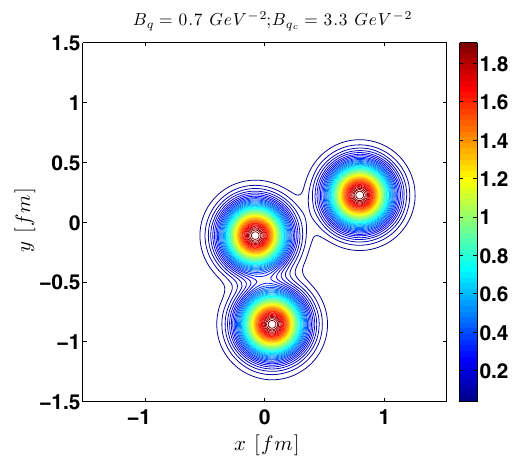
Fig. 3 Examples of a “lumpy” density profile obtained from Eq. (8) with the parameters indicated in the panel